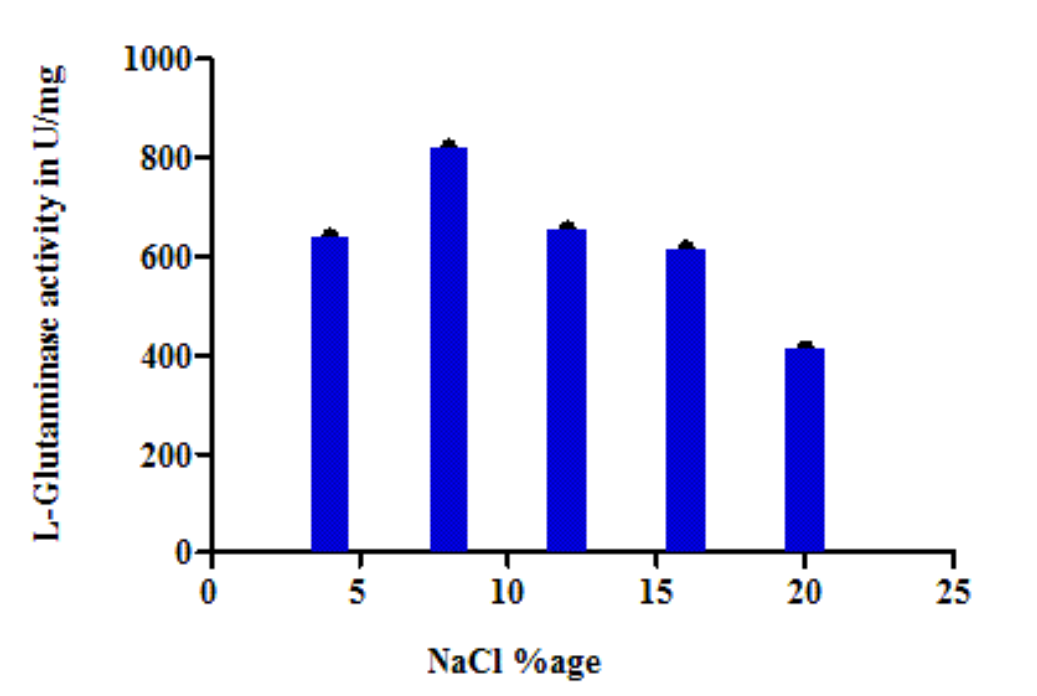
Figure 15. Effect of sodium chloride on L-glutaminase activity produced by A. xylosoxidans RSHG1 at 40 °C, pH 7.